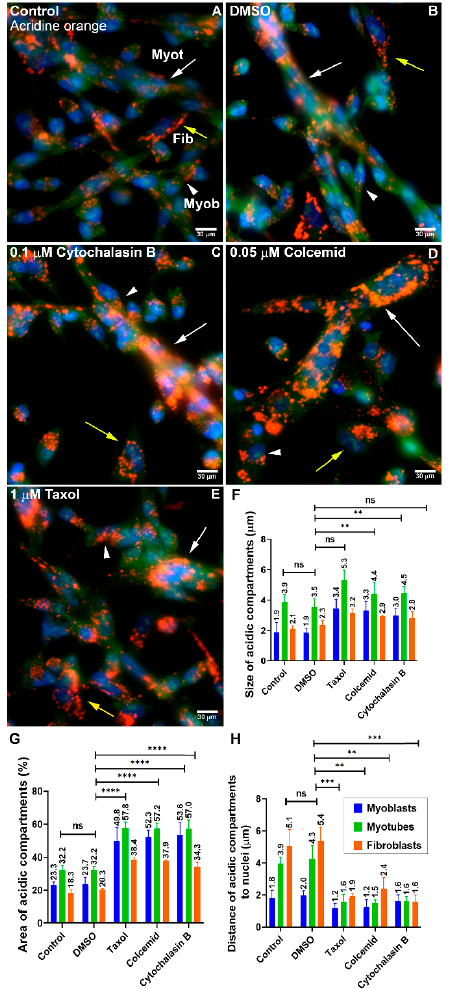
Figure 3. Effects of the disorganization of microtubules and microfilaments during chick myogenesis. Chick muscle cells were grown for 24 h and treated with Cytochalasin B, Colcemid, and Taxol for the next 24 h. Cells were labeled with acridine orange ( A – E ). White arrows represent myotubes (Myot), white arrowheads represent myoblasts (Myob), and yellow arrows represent fibroblasts (Fib). Note the increase in acridine orange labeling in cells treated with Cytochalasin B (0.1 µ M), Colcemid (0.05 µ M), and Taxol (1 µ M). Scale bars in ( A – E ) = 30 µ m. The distance to nuclei, size, and area of acridine orange-positive structures (acidic compartments) was quantified from at least fifty randomly chosen microscopic fields collected from three independent experiments ( F – H ). One-way ANOVA followed by Tukey’s multiple comparison test, ** p < 0.01, *** p < 0.001, **** p < 0.0001. Error bars denote mean ± SEM. n.s. =